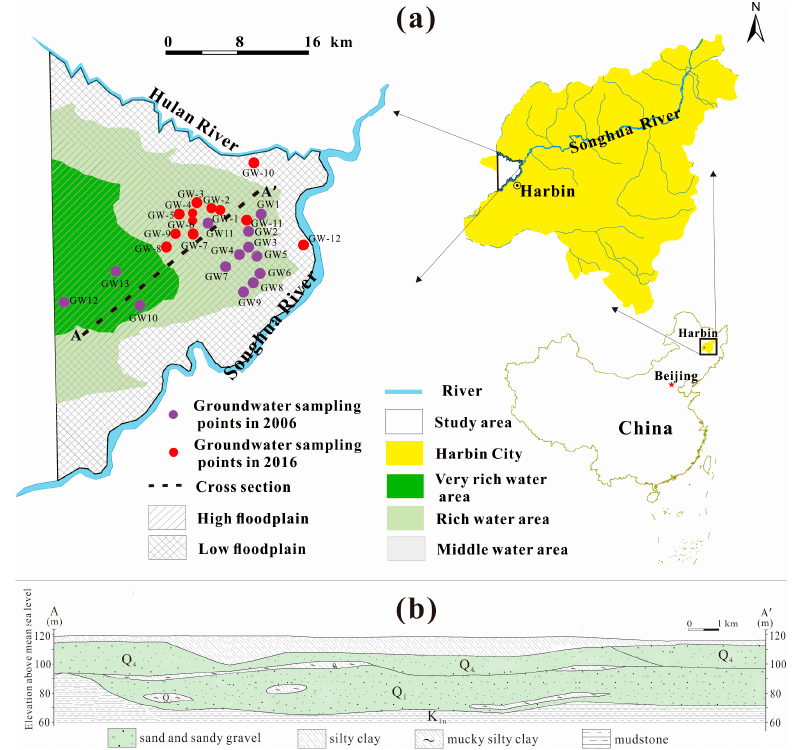
Figure 1. Study area location and distribution of sampling points ( a ) and geological section map ( b ).